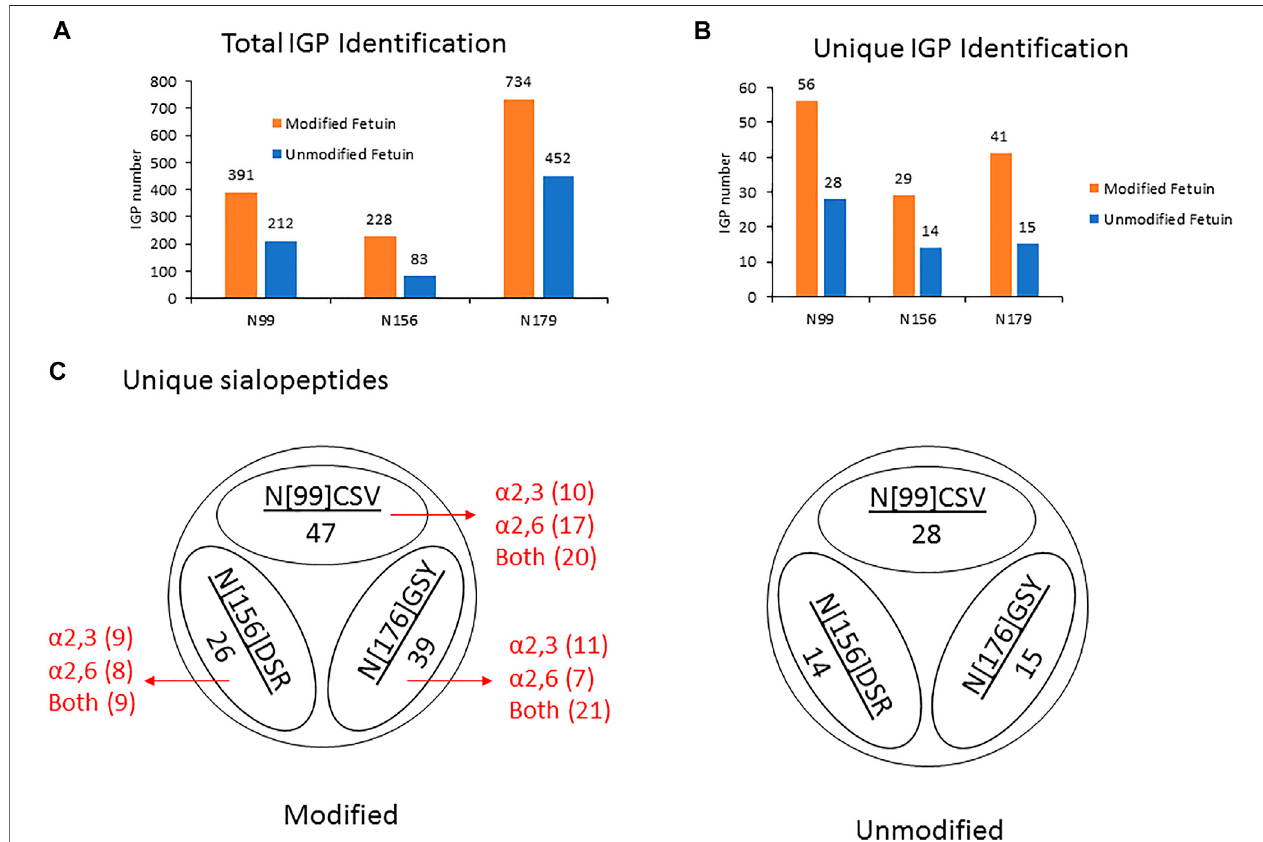
FIGURE 2 | (A,B) The site-speci fi c summary of total IGP (A) and unique IGP (B) of modi fi ed and unmodi fi ed fetuin glycopeptides (C) the site-speci fi c unique sialopeptide analysis modi fi ed and unmodi fi ed fetuin glycopeptides.